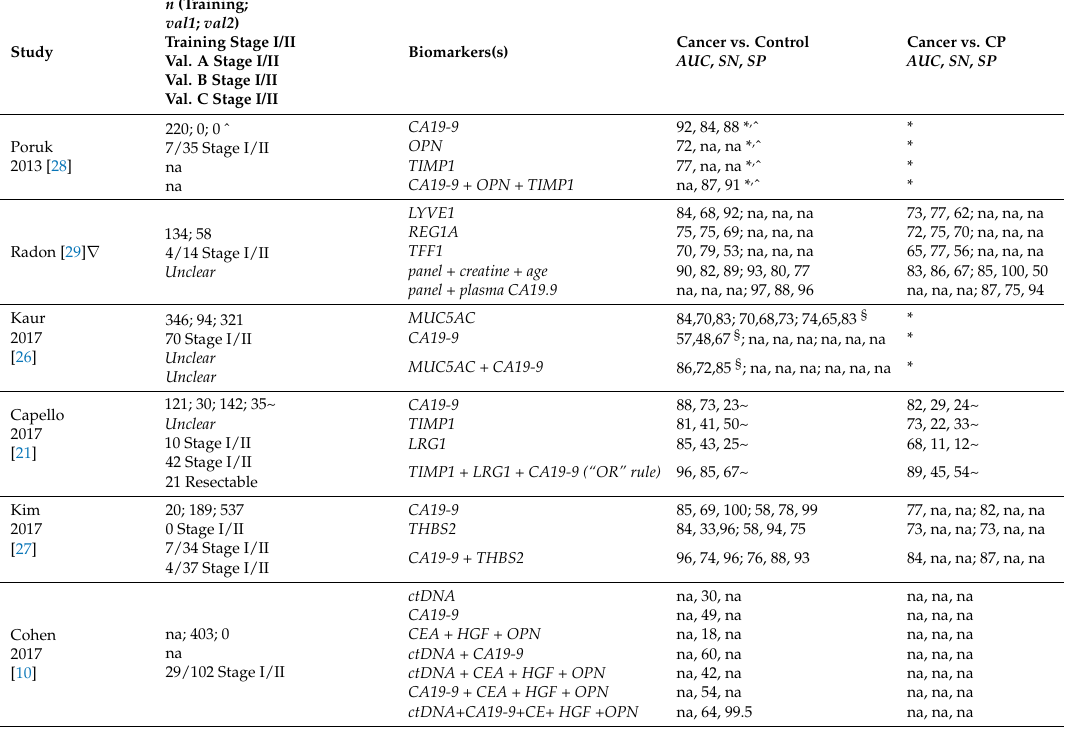
dataset used and performance reported for combined validation datasets. § Early pancreatic cancer vs. healthy controls. ∇ Stage I/II vs. healthy control or chronic pancreatitis. Molecular profiling of PDAC model systems is a widely used strategy for biomarker discovery. Cell lines, mouse models, and organoids can satisfactorily recapitulate disease progression and